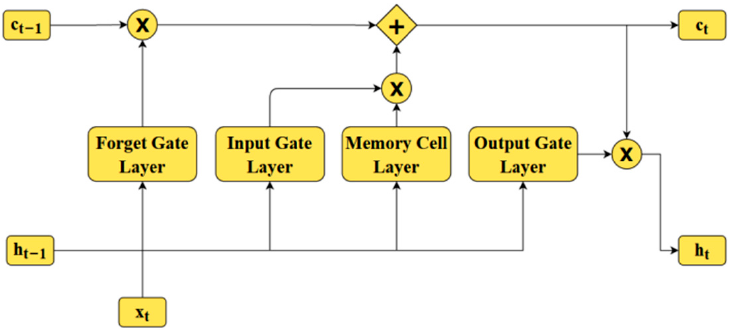
Figure A1. LSTM structure